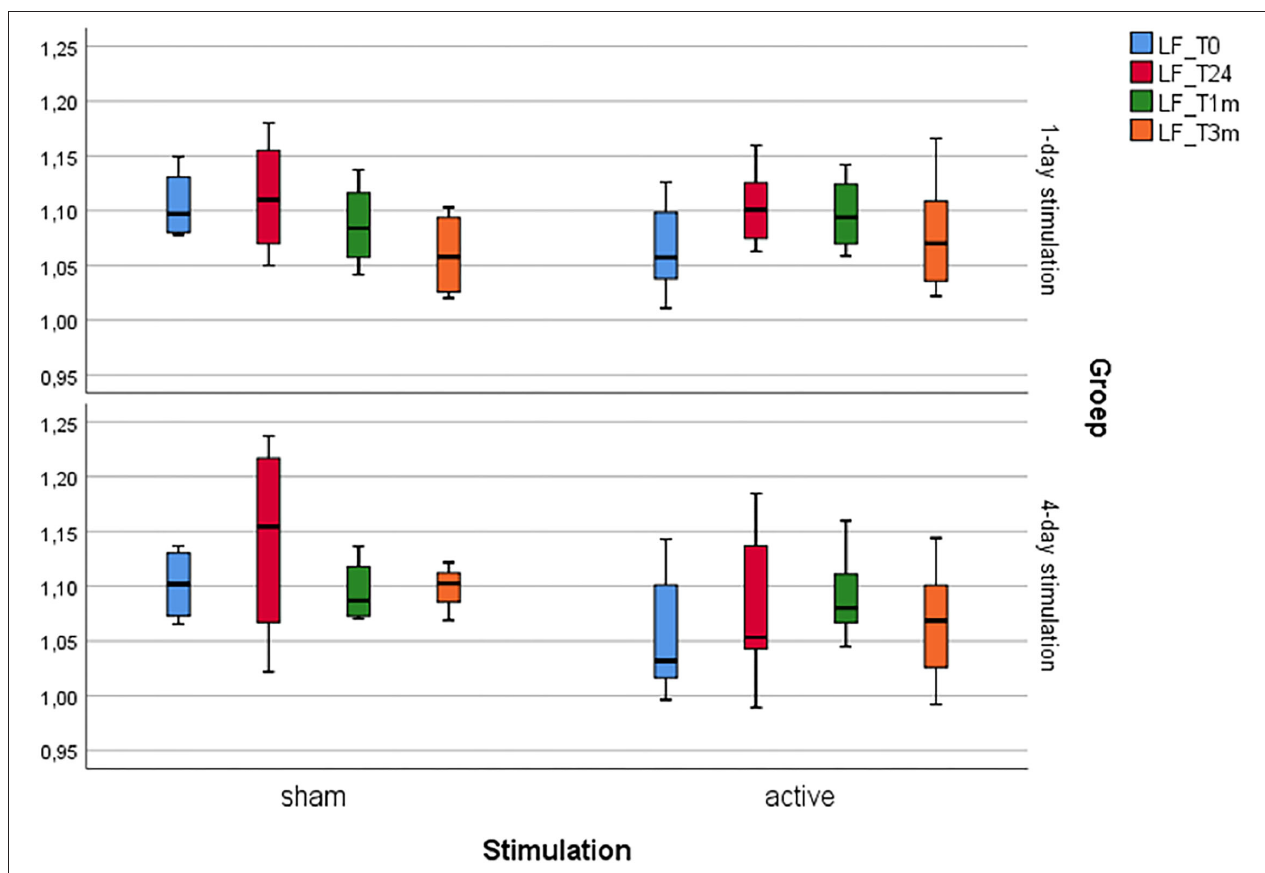
FIGURE 2 | Boxplot showing the glucose metabolism changes of the left prefrontal cortex.